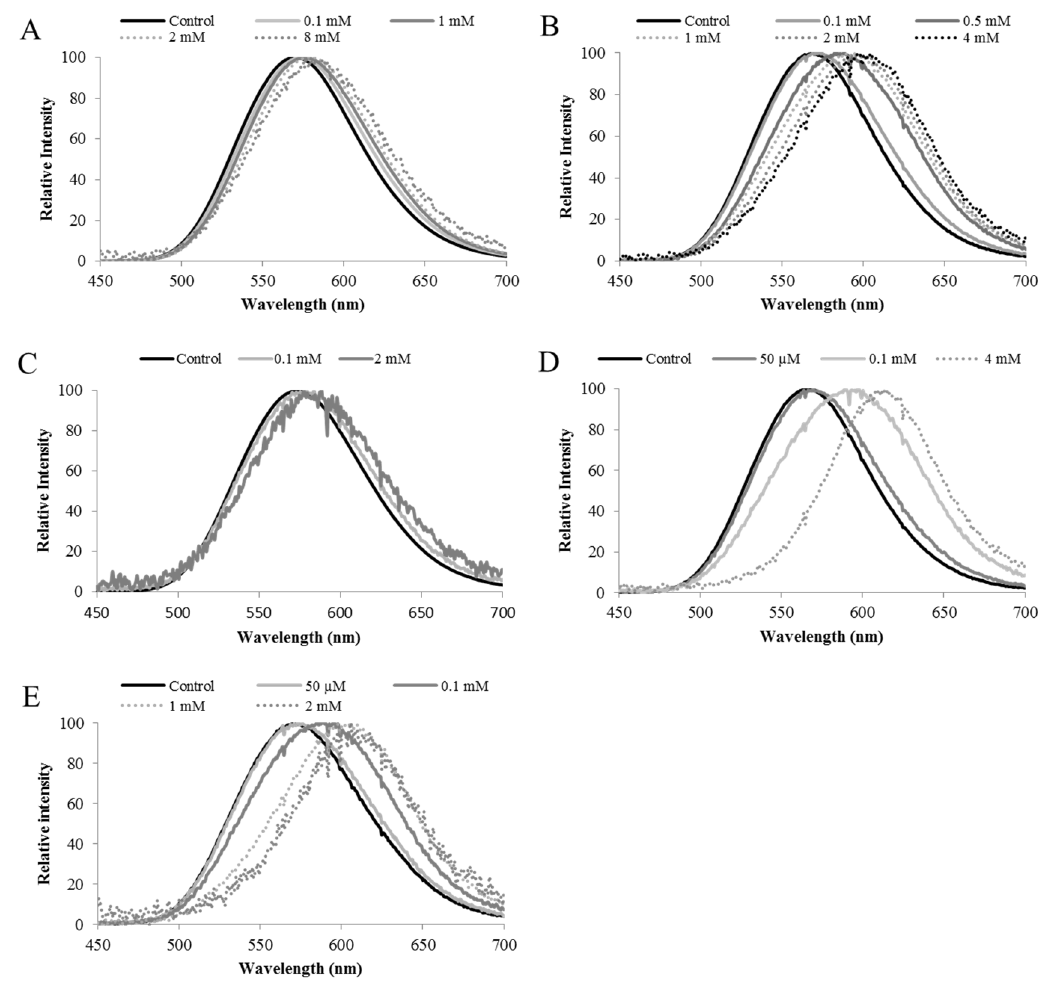
Figure 10. Bioluminescence spectra of Macrolampis sp2 firefly luciferase and its mutants showing spectral change at different concentrations of ZnSO 4 : ( A ) Wild-type; ( B ) N354H; ( C ) H310C; ( D ) N354C; ( E ) H310C/N315C; Reprinted with permission from ref. [33]. Copyright 2016 Springer. Equation (2) Ratiometric estimation of heavy metal concentration. f is the ratio between (cid:3436)𝐼610 (cid:4670)𝑀𝑒 (cid:2870)(cid:2878) (cid:4671) (cid:3404) 𝑓. 𝑅 𝐼540(cid:3440) (2) metal concentration and the ratio of intensities in the red and green